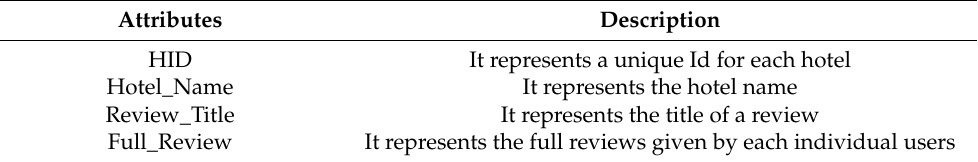
Table 5. Description of OpinkRank Hotel